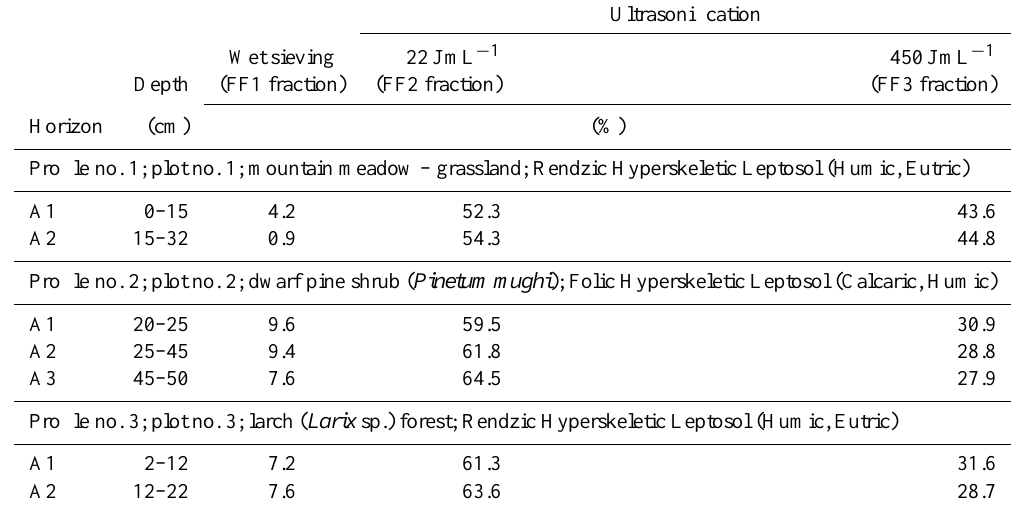
Table 3. Fraction of particles <20µm released after wet sieving and ultrasonification to the release of total fine fraction (FF).